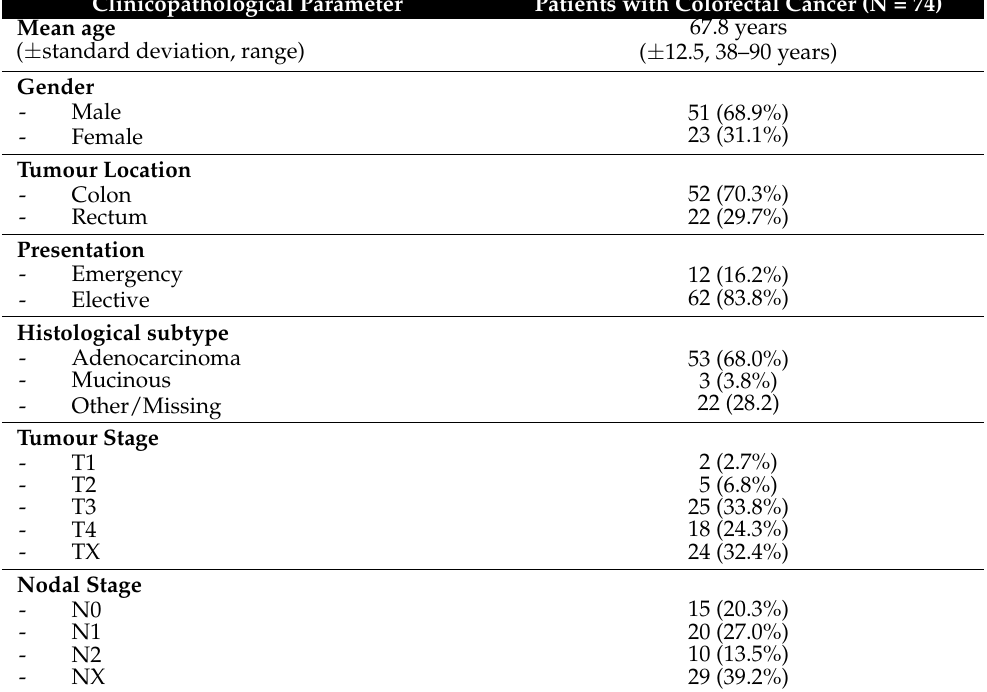
Table 1. Clinicopathogical data of the 74 patients with colorectal cancer included in this study. Clinicopathological